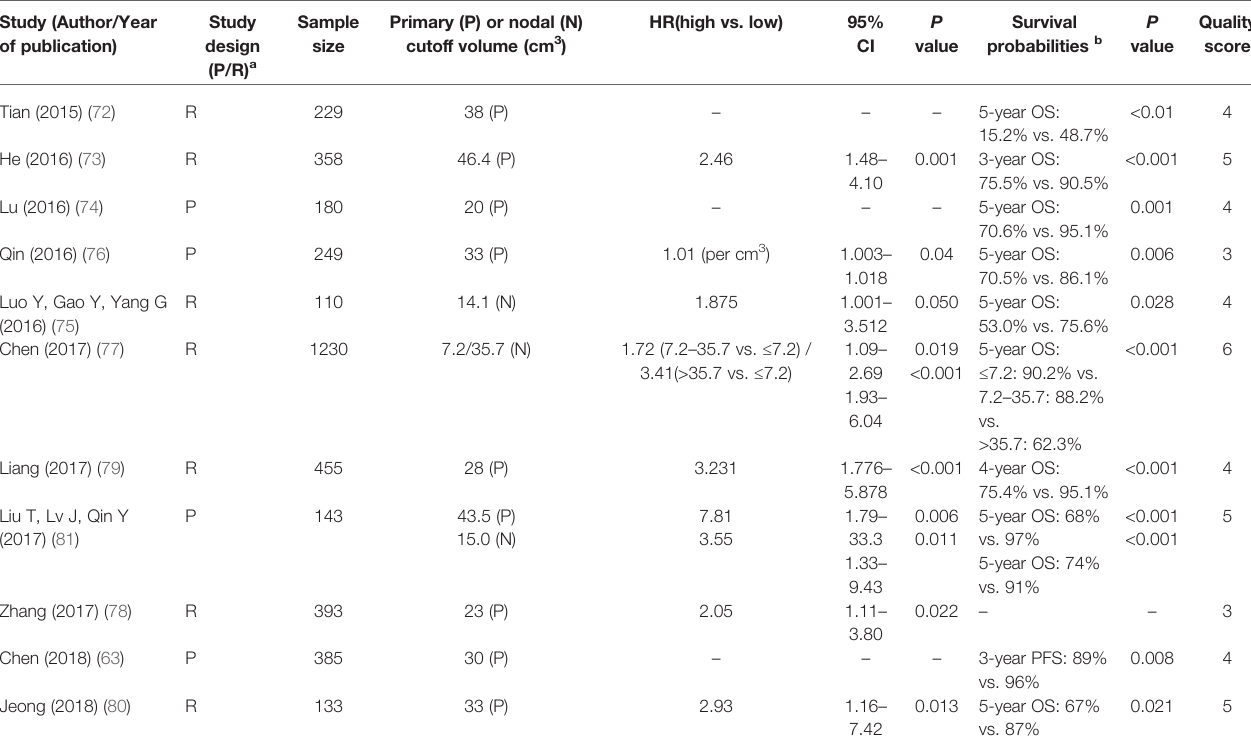
TABLE 4 | Association of overall survival with tumor volume (n=11).